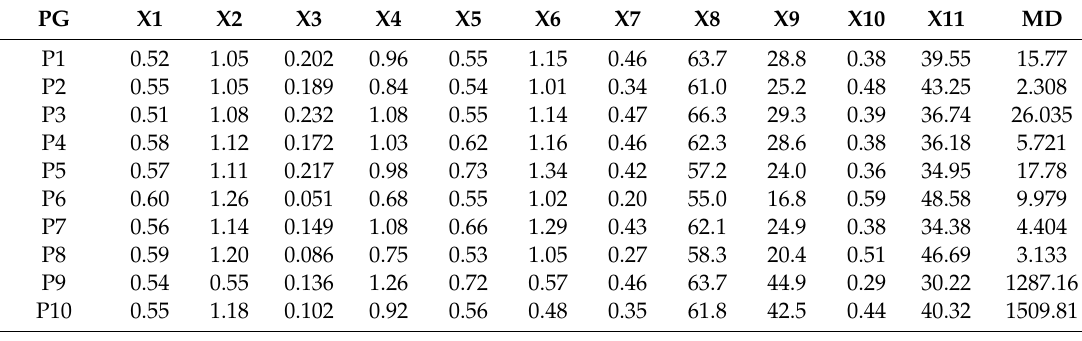
Table 9. MD for ACLR group (PG)